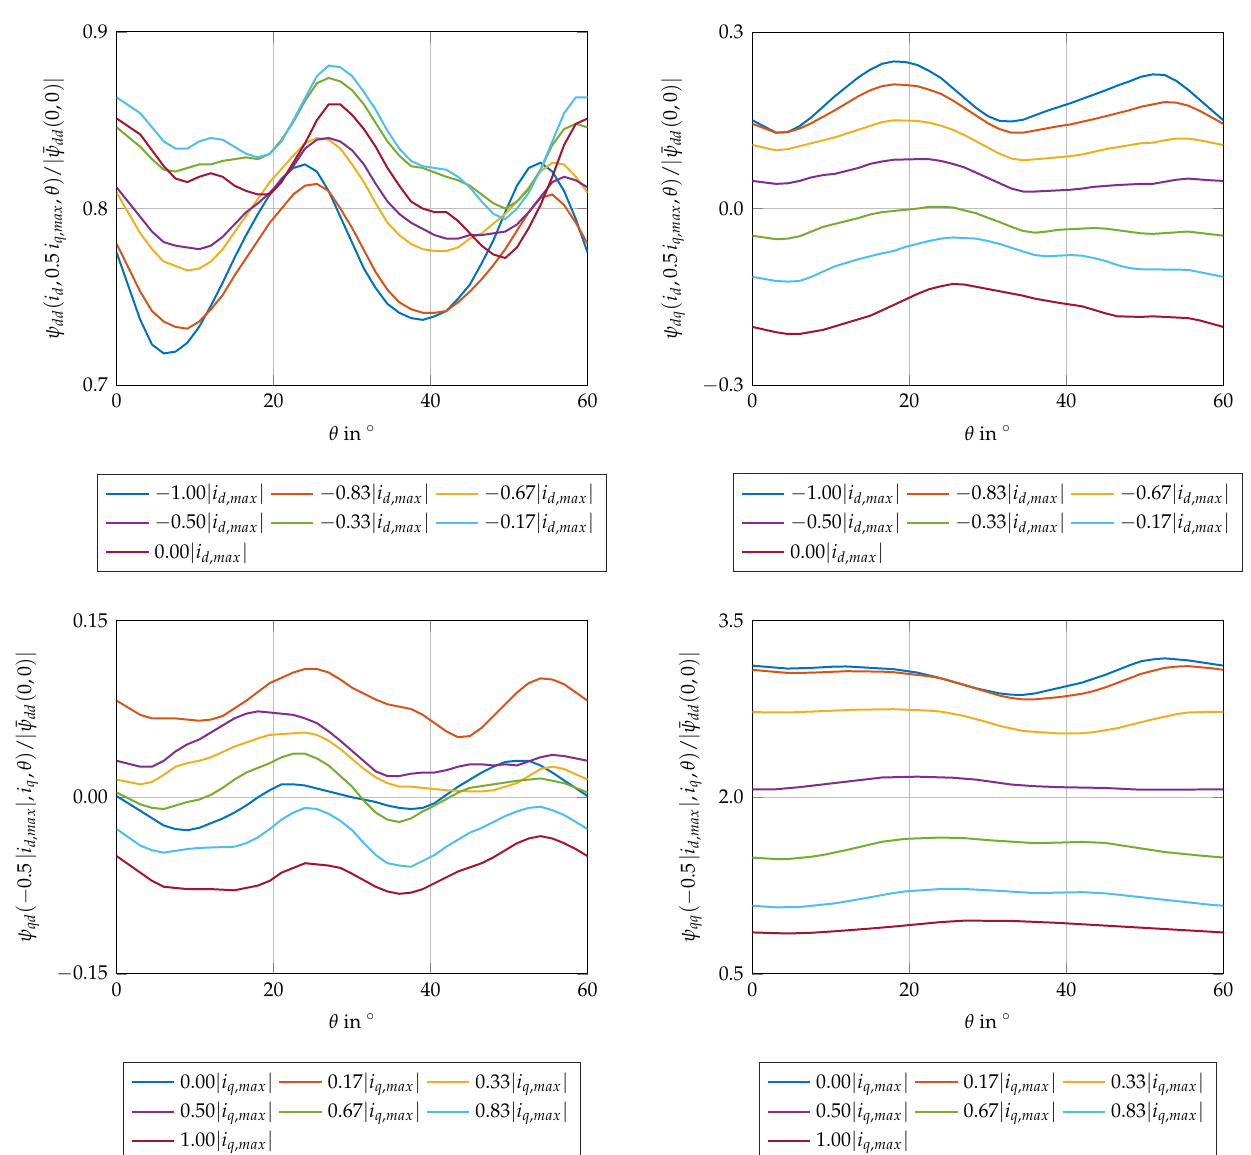
Figure 2. Exemplary normalised partial derivatives of the flux